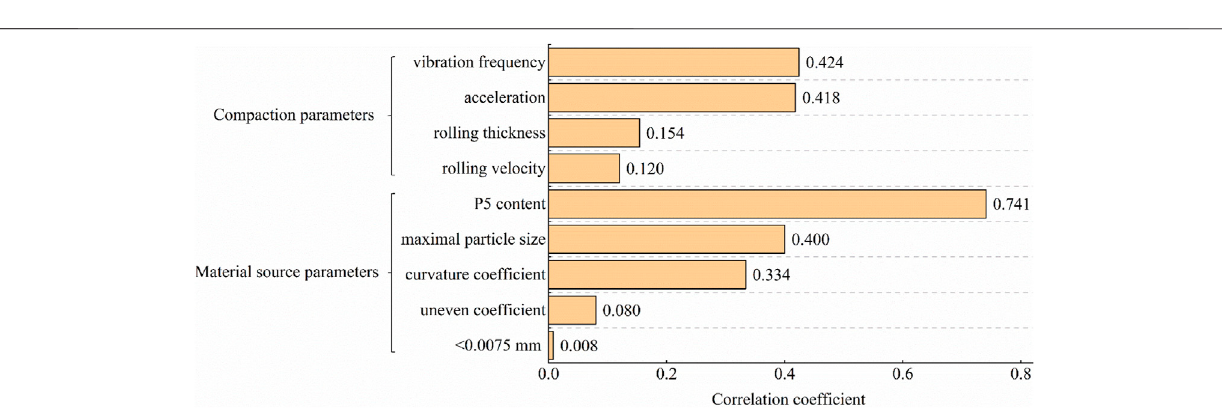
FIGURE 9 | Correlation coef fi cient between each feature and compaction